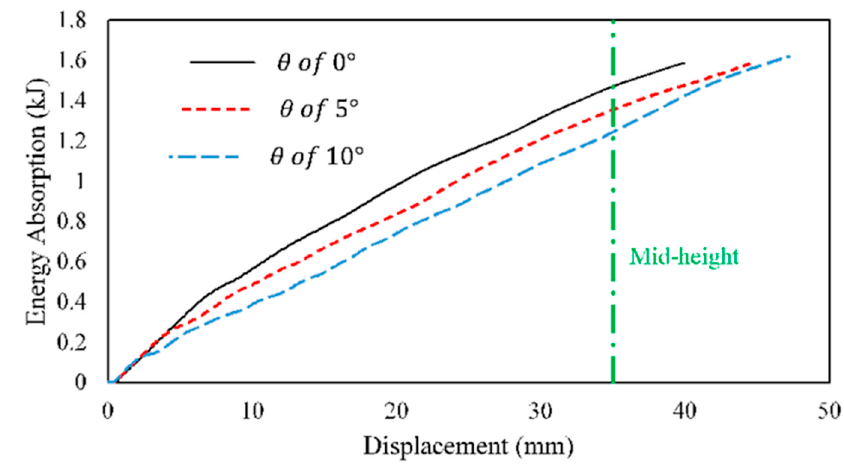
Figure 11. Plot of energy absorption-displacement curves of panels 4–1–0.6– θ –3.